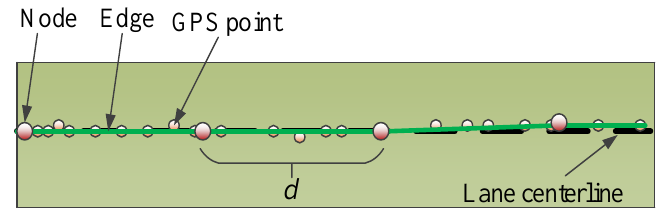
Figure 2. Map-building in general path.